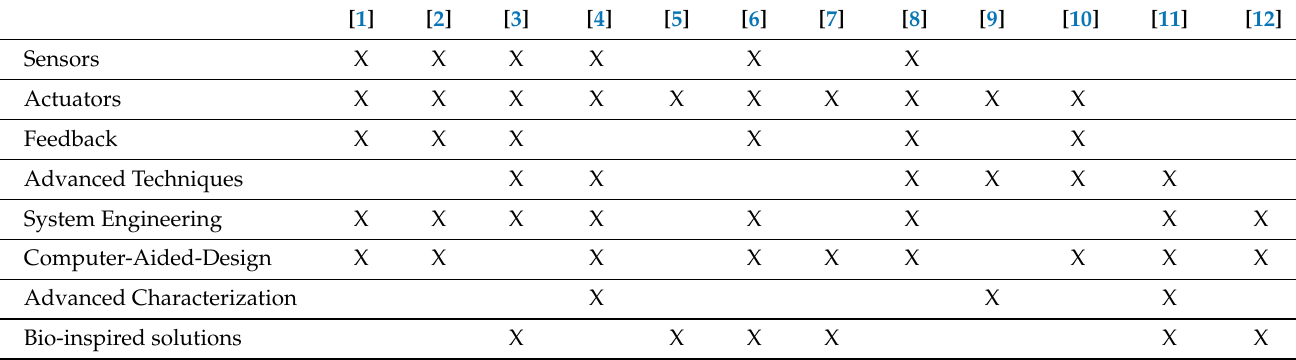
Table 1. Correlation matrix of the selected